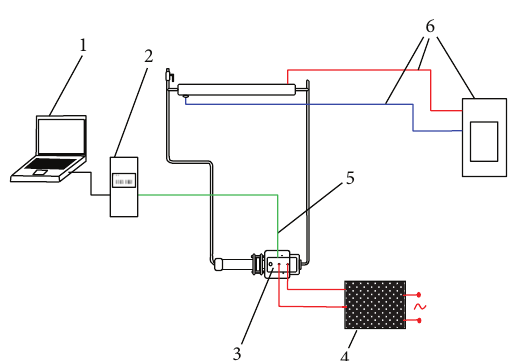
Figure 7: Schematic diagram of measuring device: 1: PC, 2: logger, 3: IGBT, 4: power supply voltage and current, 5: thermocouple, and 6: thermostat.